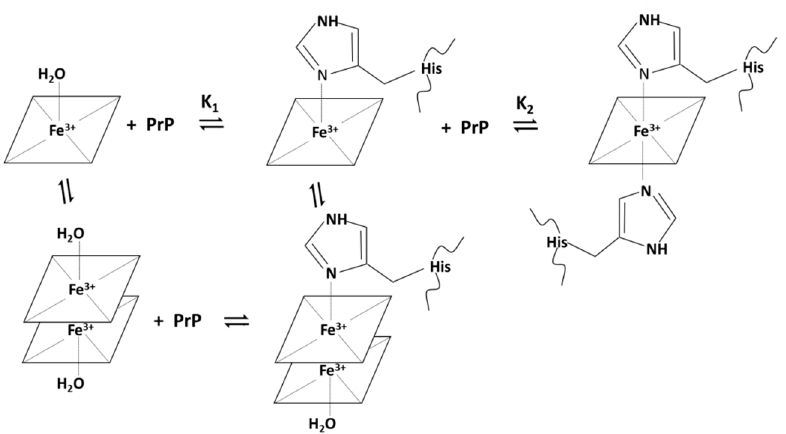
Figure 1. Binding equilibria of PrP histidine-containing peptides to monomeric and dimeric hemin with possible formation of five-coordinated high-spin hemin complex (equilibrium ruled by K 1 ) or six-coordinated low-spin hemin:PrP complex (equilibrium ruled by K 2 ).